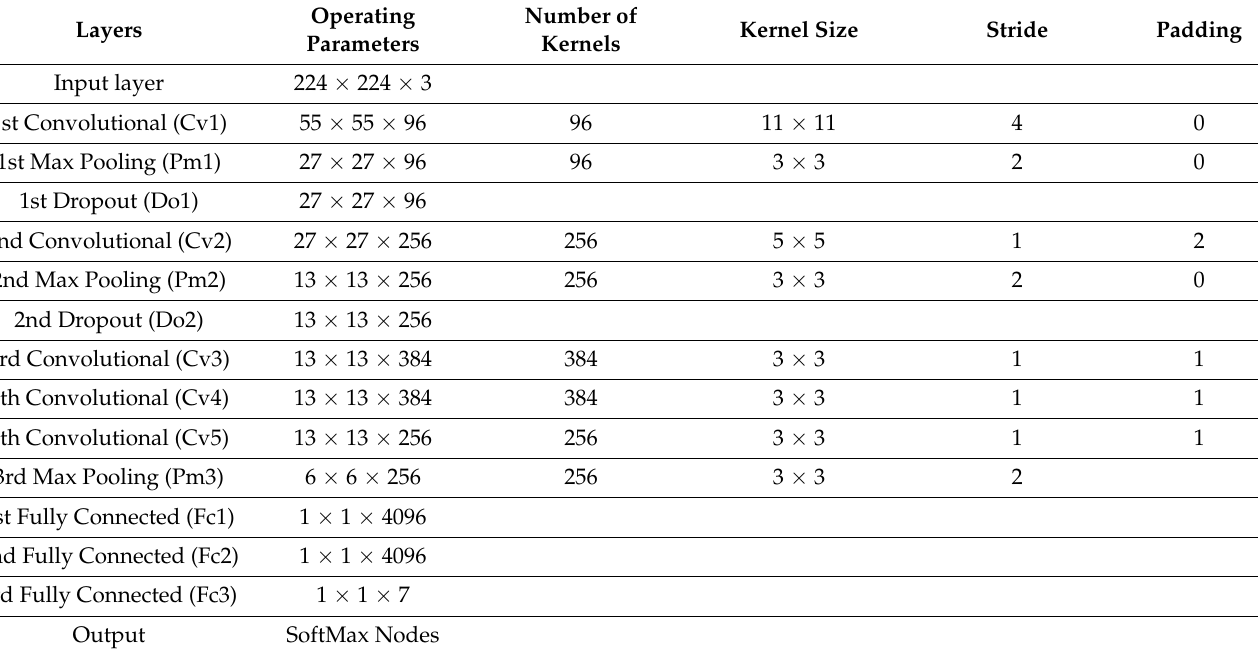
Table 3. The structural elements of the proposed DCNA.